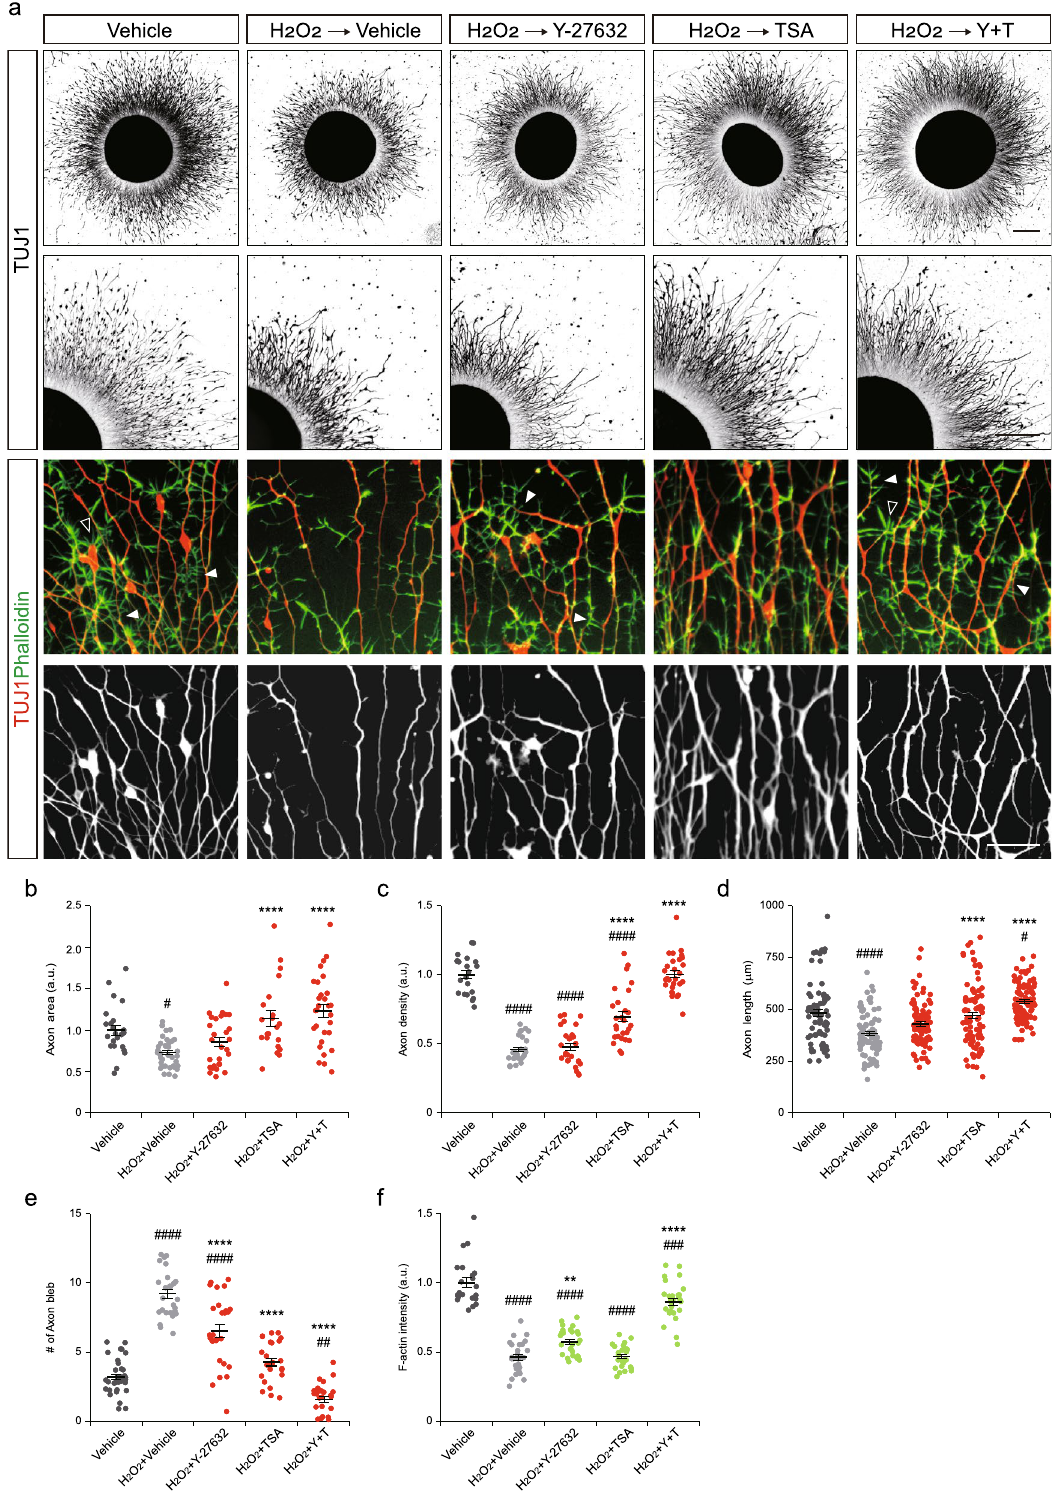
Figure 4. Pharmacological intervention of cytoskeletal dynamics after oxidative stress suppresses axon degeneration. ( a ) Representative images of motor nerve organoids treated with Y-27632 (10 μM) and TSA (10 μM) for 12 h after 100 μM of H 2 O 2 for 6 h. Lower-panel images show high-magnification views of the upper-panel images. Some fine protrusions at the axon shaft (closed arrowheads) and radially projected filopodial structures (open arrowheads) were marked. Scale bars 250 μm (upper and middle panels), and 30 μm (lower panels). ( b – f ) Axonal area ( b ) (n = 24–38 organoids per condition), density ( c ) (n = 21–28 images per condition), length ( d ) (n = 70–90 axons per condition), the number of axon blebs ( e ) (n = 26–37 images per condition), actin fluorescence intensity ( f ) (n = 22–30 images per condition) in drug-treated organoids. Error bars represent s.e.m.; # p < 0.05, ## p < 0.01, ### p < 0.001, #### p < 0.0001 versus Vehicle; **p < 0.01, ****p < 0.0001 versus H 2 O 2 + Vehicle, one-way ANOVA test with Tukey’s